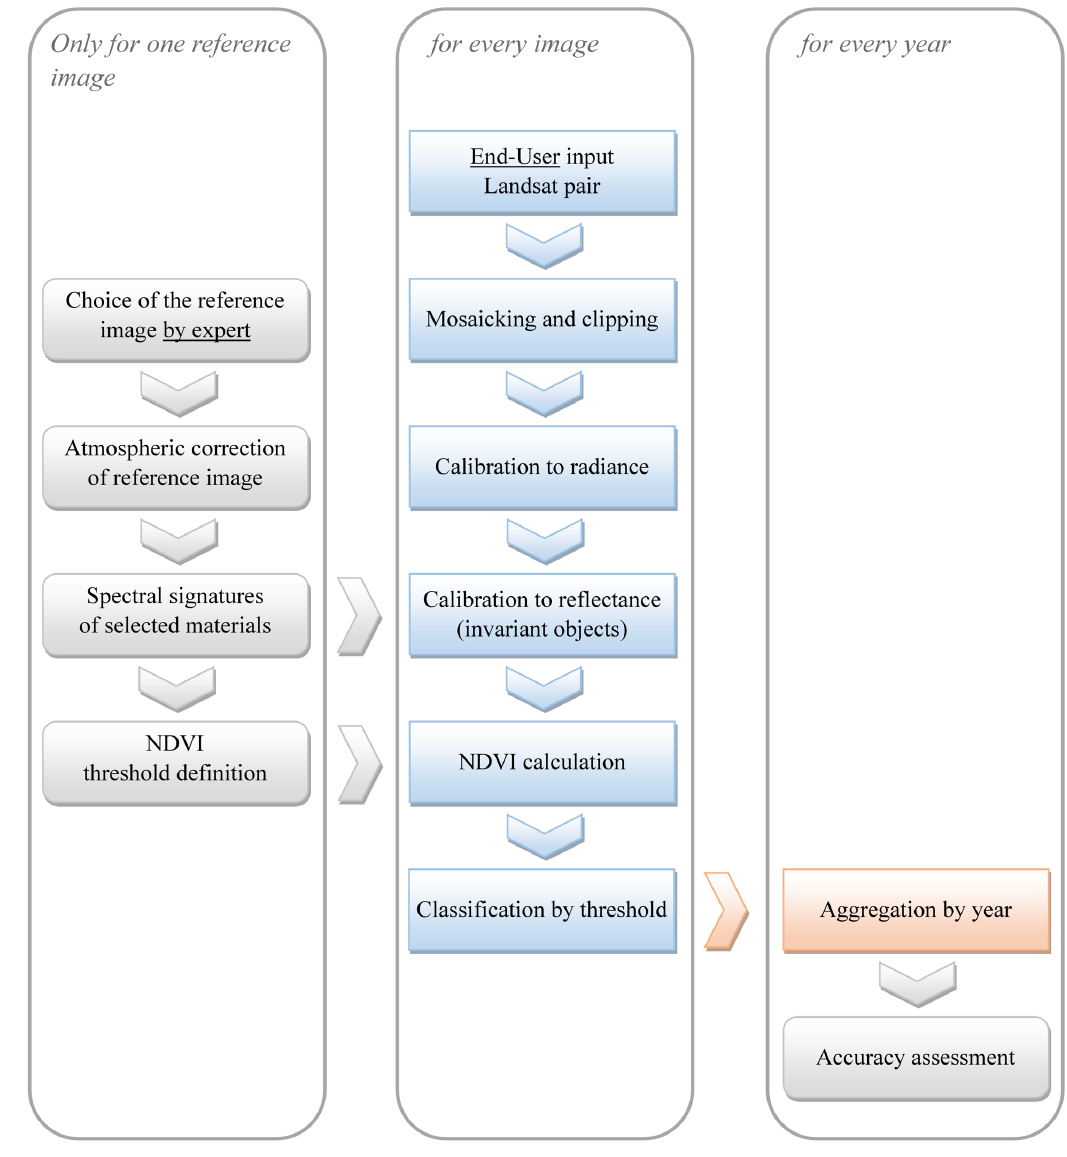
Figure 2. Block diagram outlining the main processing steps implemented in the automated